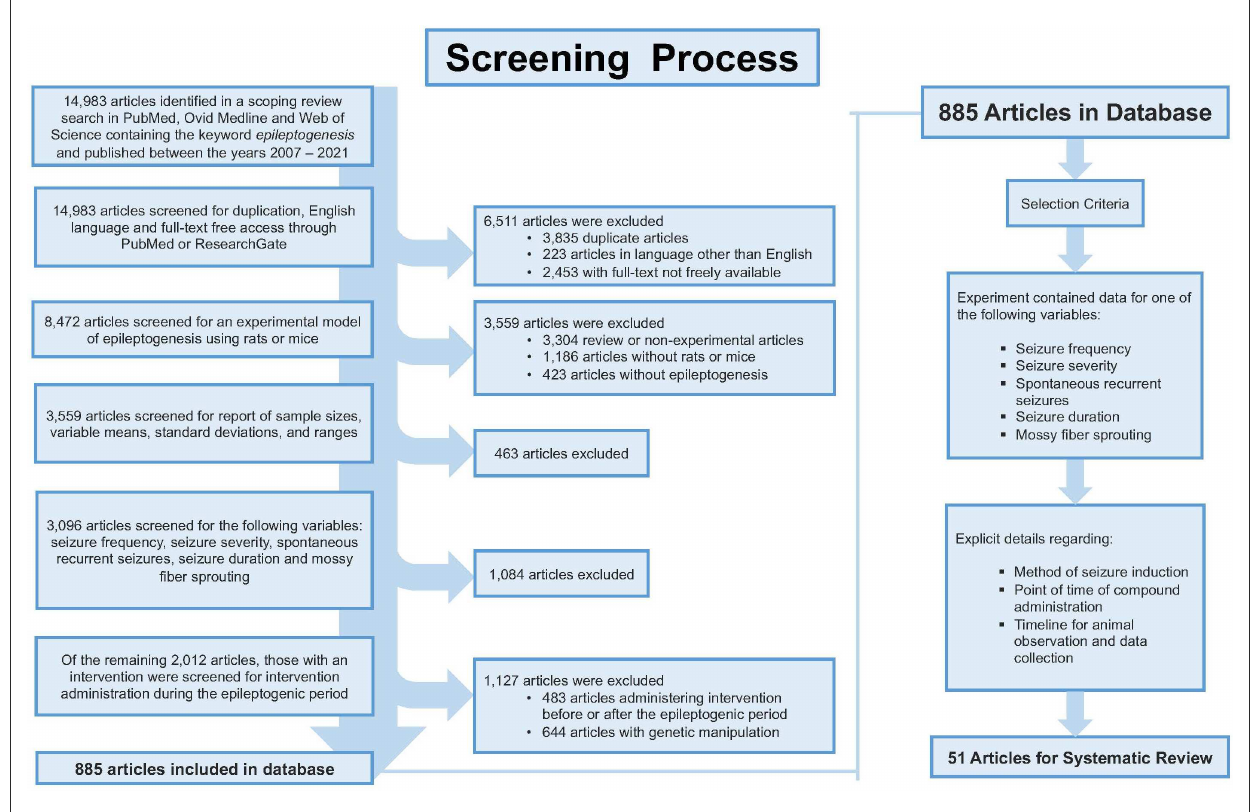
plotted together in a bar graph displaying the percent change in ascending